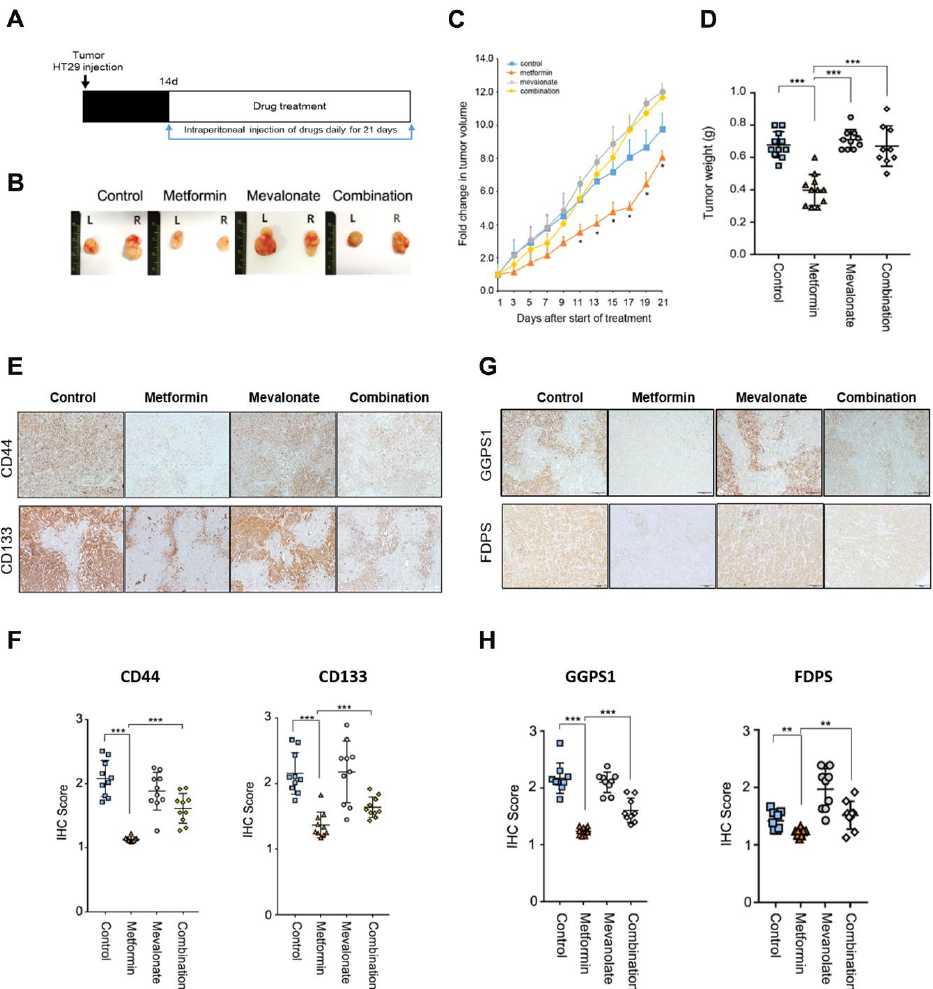
Figure 4. The tumor-suppressing effect of metformin was reversed by addition of mevalonate in a mouse xenograft model. ( A , B ) HT29 cells were injected subcutaneously into both flanks of nude mice. Implanted mice were randomly and evenly allocated into four groups: vehicle, metformin (by intraperitoneal injection, 250 mg/kg in 200 μl PBS daily), mevalonate ( by intraperitoneal injection, 10 mg/kg in 200 μl PBS daily), or the combination of the same daily doses of both metformin and mevalonate. Tumors were measured, and mice were sacrificed on day 21. In mice implanted with HT29 cells, tumor growth ( C ) and tumor weights ( D ) were compared between the four groups. In ( C ), * denotes p < 0.05 for comparison with the combination group. ( E ) IHC to evaluate expression of CD44 and CD133 was performed on sections of formalin-fixed, para ffi n-embedded, dissected xenograft tumor samples from mice treated with vehicle, metformin alone, mevalonate alone, or metformin combined with mevalonate. ( F ) IHC scores for CD44 or CD133-stained cells were analyzed using Image J. ( G ) IHC was performed for FDPS and GGPS1 and ( H ) analyzed using Image J. Magnification, 200 × . Data are expressed as the mean ± standard error; n = 10 per group. * p < 0.05, ** p < 0.01, and *** p <